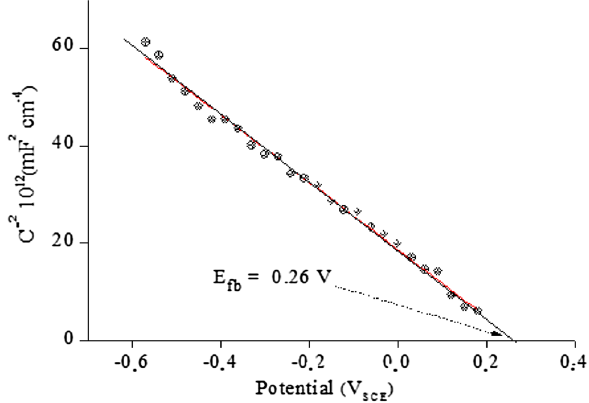
Fig. 5 The Mott–Schottky plot of p -type ZnCo